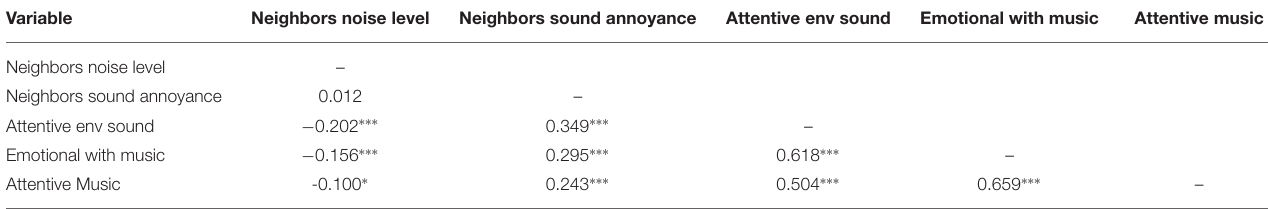
TABLE 14 | Correlations between the variables on perception and recognition of noise, environmental sounds, and music.